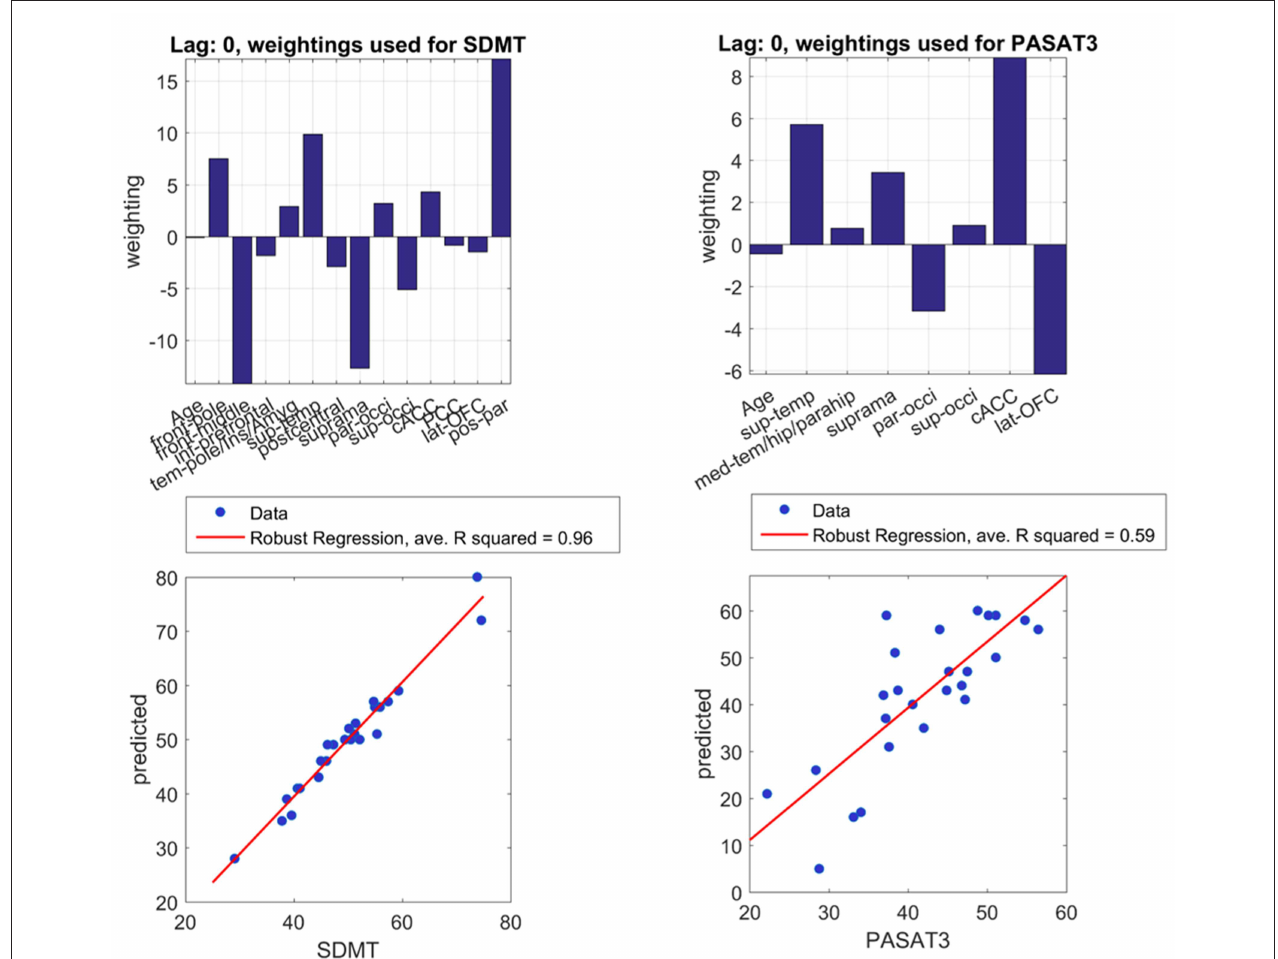
FIGURE 2 | Important brain regions for cognitive performances. With least absolute shrinkage and selection operator (LASSO) regression, the upper left and upper right panels express weights of important connectivity pairs in predicting SDMT and PASAT, respectively. The lower panel shows positive correlations between real scores and predicted scores of SDMT and PASAT with the limited number of pairs. Real and predicted SDMT scores especially demonstrate a good correlation with average R 2 = 0.96 in leave-one-out calculation. Predicted and real PASAT scores also show a strong correlation with average R 2 = 0.59. Abbreviations are shown in Table 2 . PASAT3, Paced Auditory Serial Addition Test-3s; SDMT, Symbol Digit Modalities